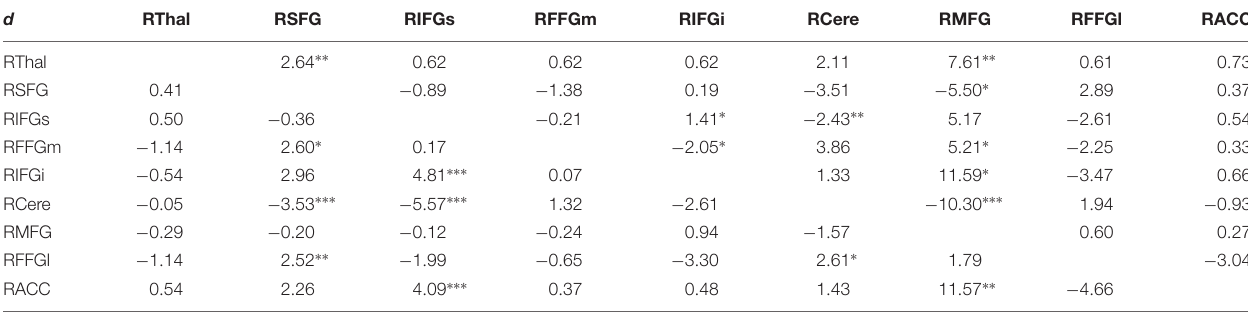
TABLE 2 | Group means of non-linear connectivity coefficients ( d coefficients).